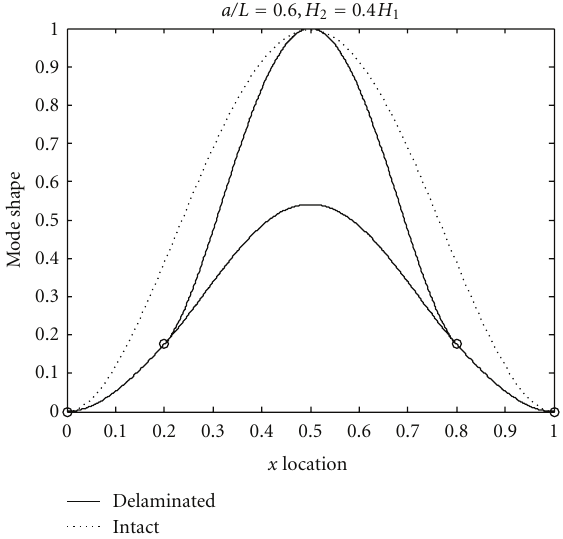
Figure 5: The first opening mode for a delaminated beam with top beam thickness equal to 40% the height of the intact beam; 60% of span, o ff -midplane